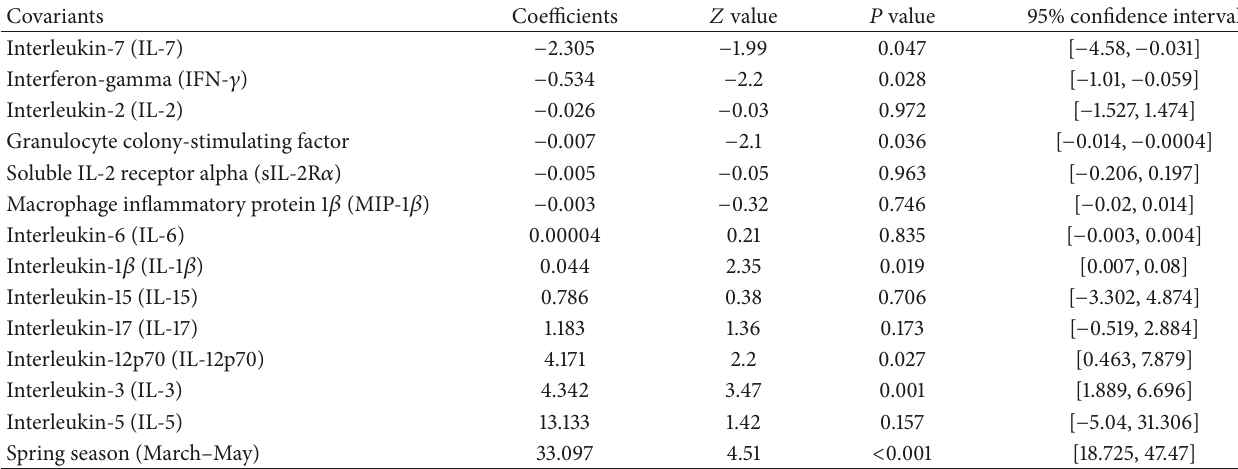
Table 1: Correlations between significant cytokines and chemokines with antigen induced IFN- 𝛾 level in QFT. Covariants